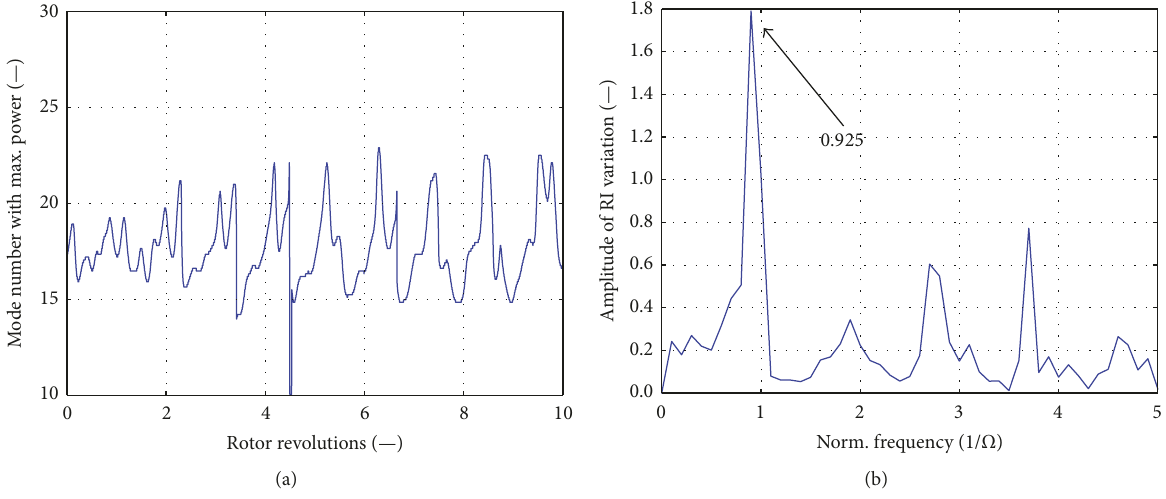
Figure 11: Frequency variation of rotating instability over time: temporal evolution (a); frequency spectrum (b).